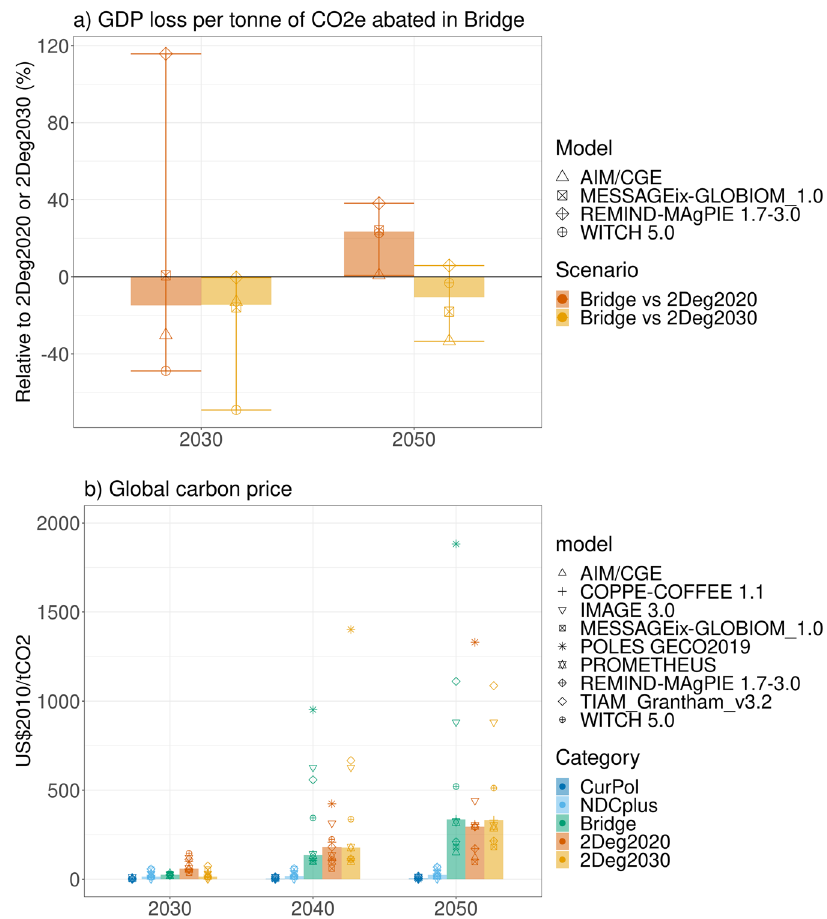
Fig. 4 Cost indicators for the Bridge scenario, compared to the other scenarios. Panel a GDP (in market exchange rates, MER) loss (relative to the CurPol scenario) in Bridge, relative to 2Deg2020 (dark orange) and 2Deg2030 (yellow), for 2030 (left) and 2050 (right). Panel b Carbon price (US$2010/tCO 2 ), in 2030, 2040 and 2050. Bars: median, error bars: full range, symbols: individual